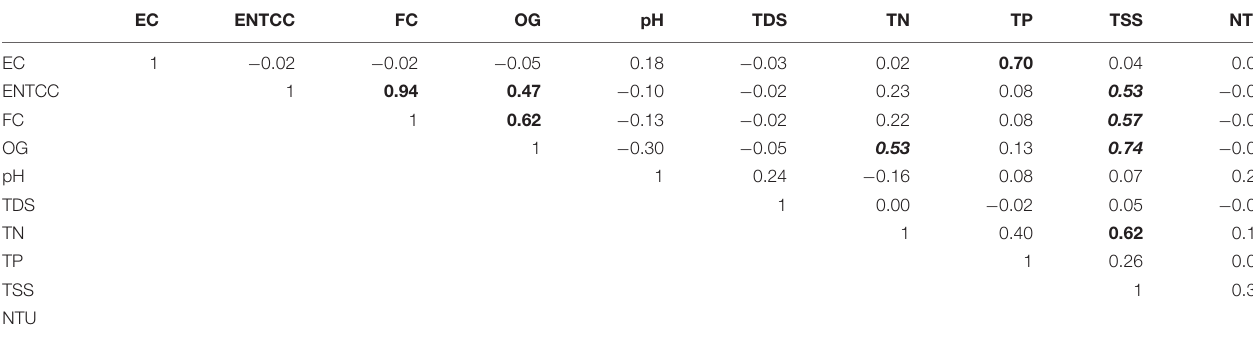
TABLE 4 | Covariance matrix of water quality parameters (r).